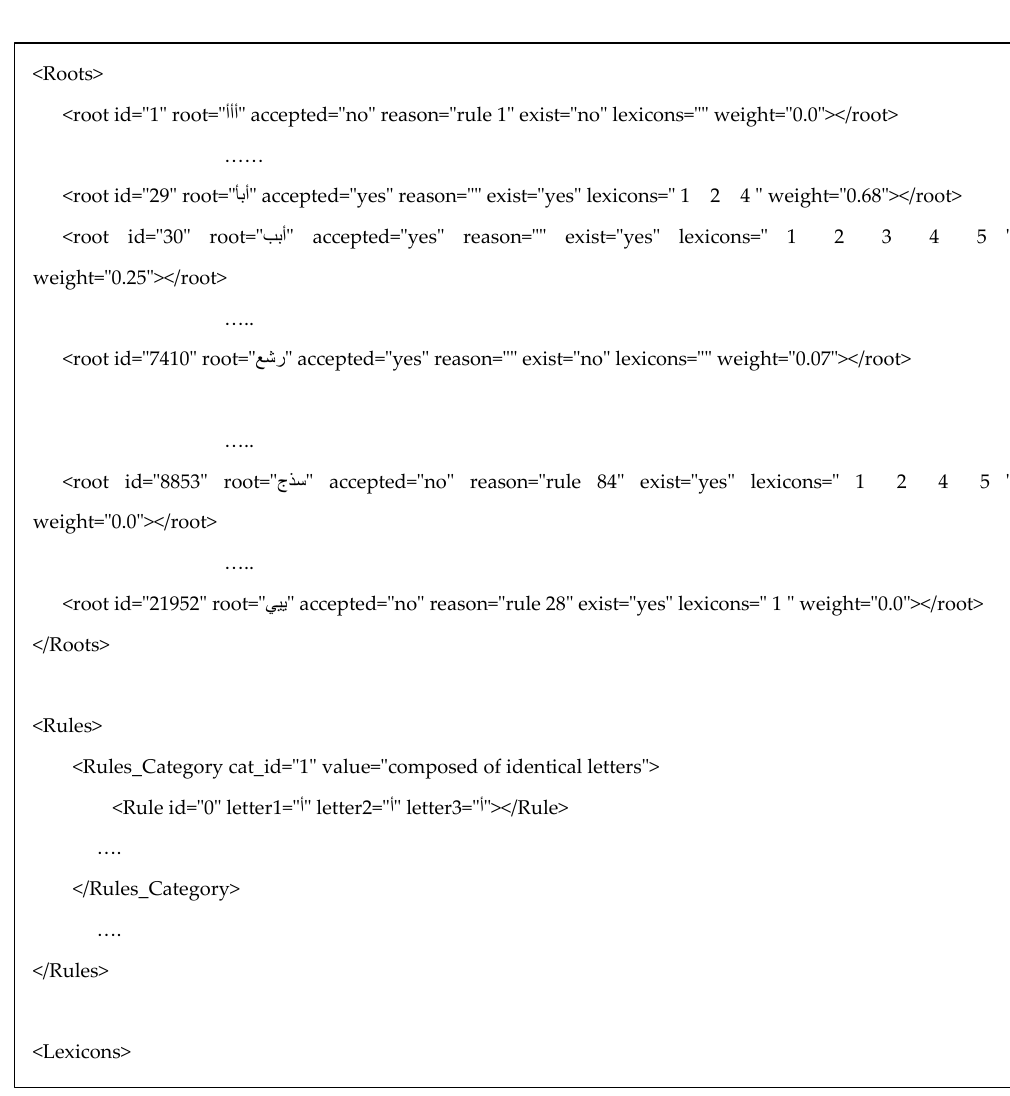
Table 3. Three-Letter Combinations Statistics.